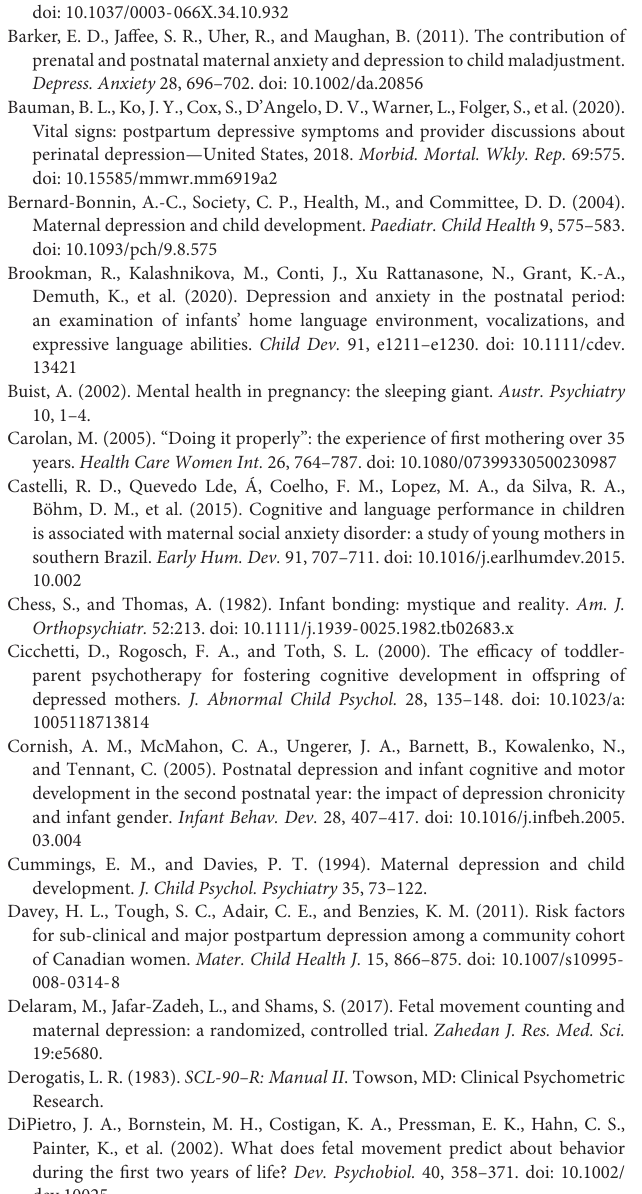
Figueiredo,B.,Canário,C.,andField,T.(2014).Breastfeedingisnegativelyaffected by prenatal depression and reduces postpartum depression. Psychol. Med.